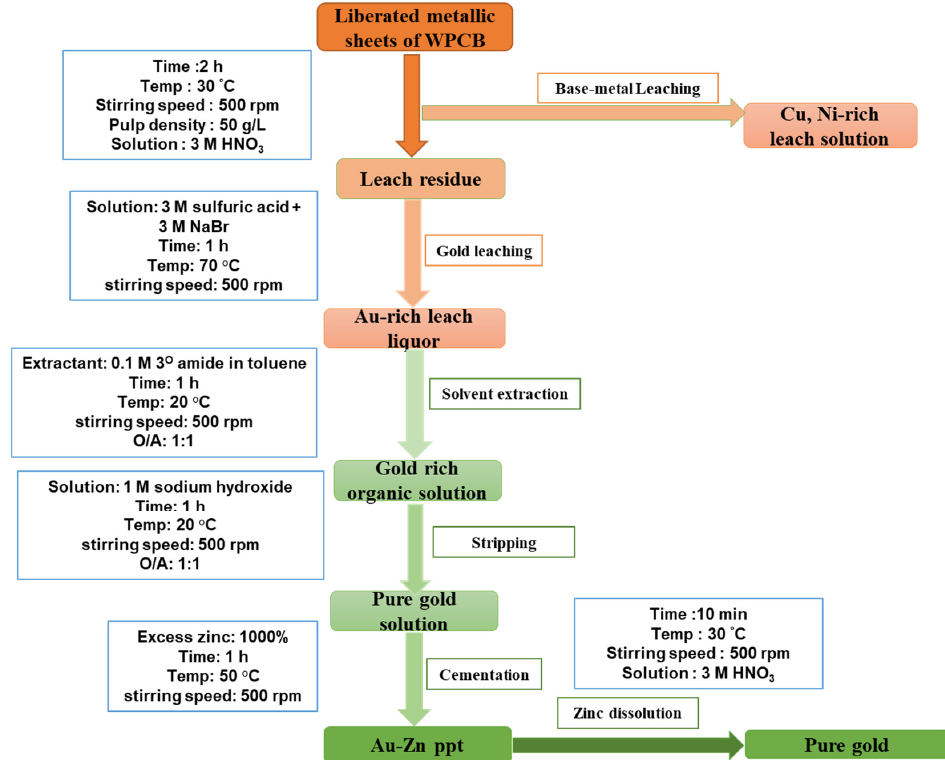
Figure 1. Flowsheet of the proposed process.